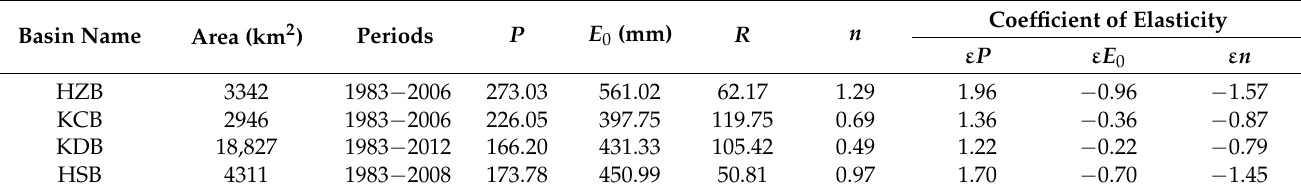
Table 2. Values of climatic and hydrological variables in HZB, KCB, KDB, HSB during summer (June to September).